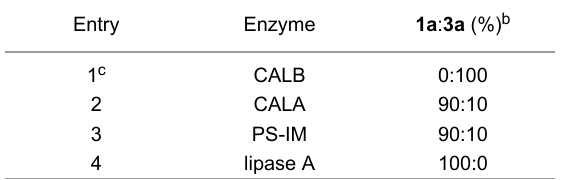
Table 1: Influence of various enzymes on the esterification of erythro - 1a with isopropenyl acetate ( 2a ) in the ball mill. a